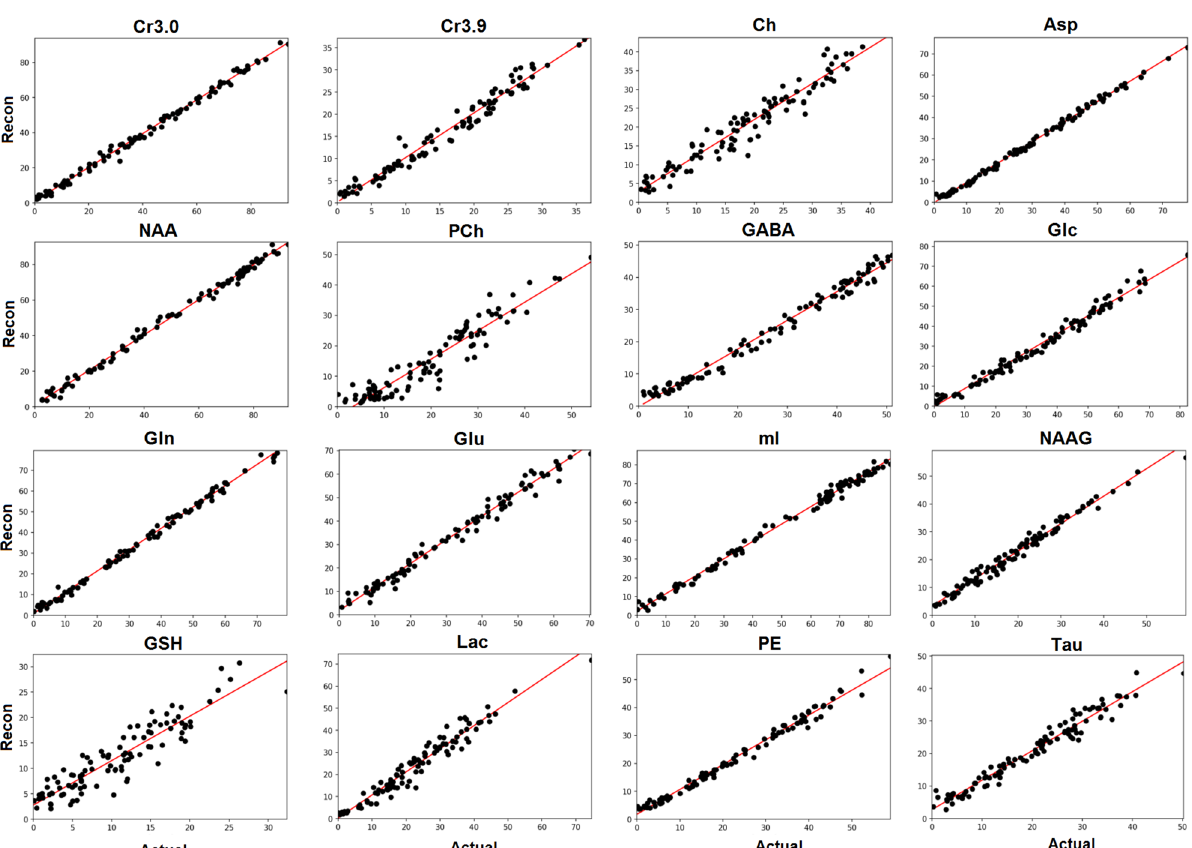
Figure 8. The relationship between the actual metabolite concentration on the x-axis (Actual) and the reconstructed metabolite concentration on the y-axis (Recon) is shown for 16 metabolites for 100 test spectra. The spectra contained approximately 5% noise signal relative to the maximum signal intensity (noise level = 2). Overall, most metabolites displayed an expected linear relationship even at lower concentration values. Quantitative values for these results are tabulated in Table Fig. 8. While these pilot results look promising for reconstruction and quantitation of L-COSY spectra, the cur- rent implementation of this method has several weaknesses. First, the D-UNet model requires prior-knowledge for all metabolites present in the tissue for training as well as how these signals are affected by a particular non-uniform sampling pattern. Compressed sensing reconstruc- tions do not require any spectral prior-knowledge, and therefore are more versatile for different sampling masks. This is not necessarily a weakness if: (1) the sampling mask used for acquisition matches the D-UNet sampling